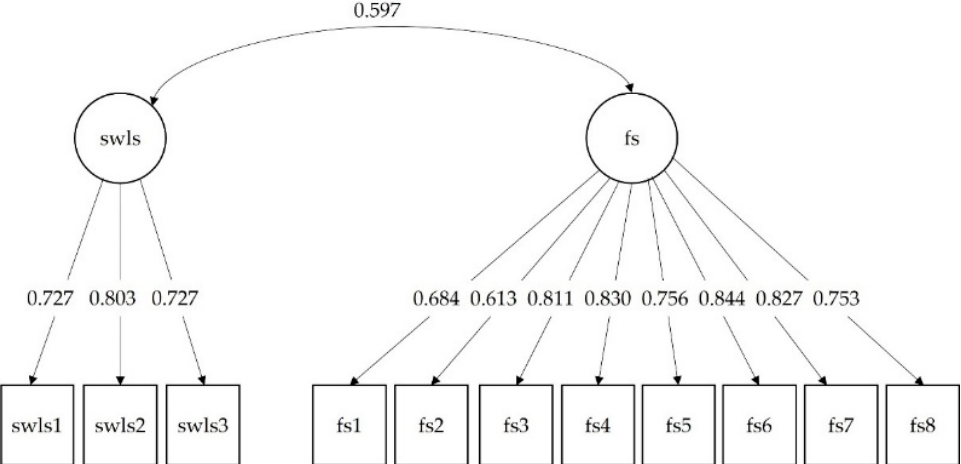
Figure 1. Standardized values for the structural equation model of the 3-item version of the Satisfaction with Life Scale (SWLS) and the Flourishing Scale (FS). Note: swls = Satisfaction with Life Scale; fs = Flourishing Scale; swls1 = In most ways, my life is close to my ideal; swls2 = I am satisfied with my life; swls3 = The conditions of my life are excellent. All coefficients are statistically significant ( p < 0.001).